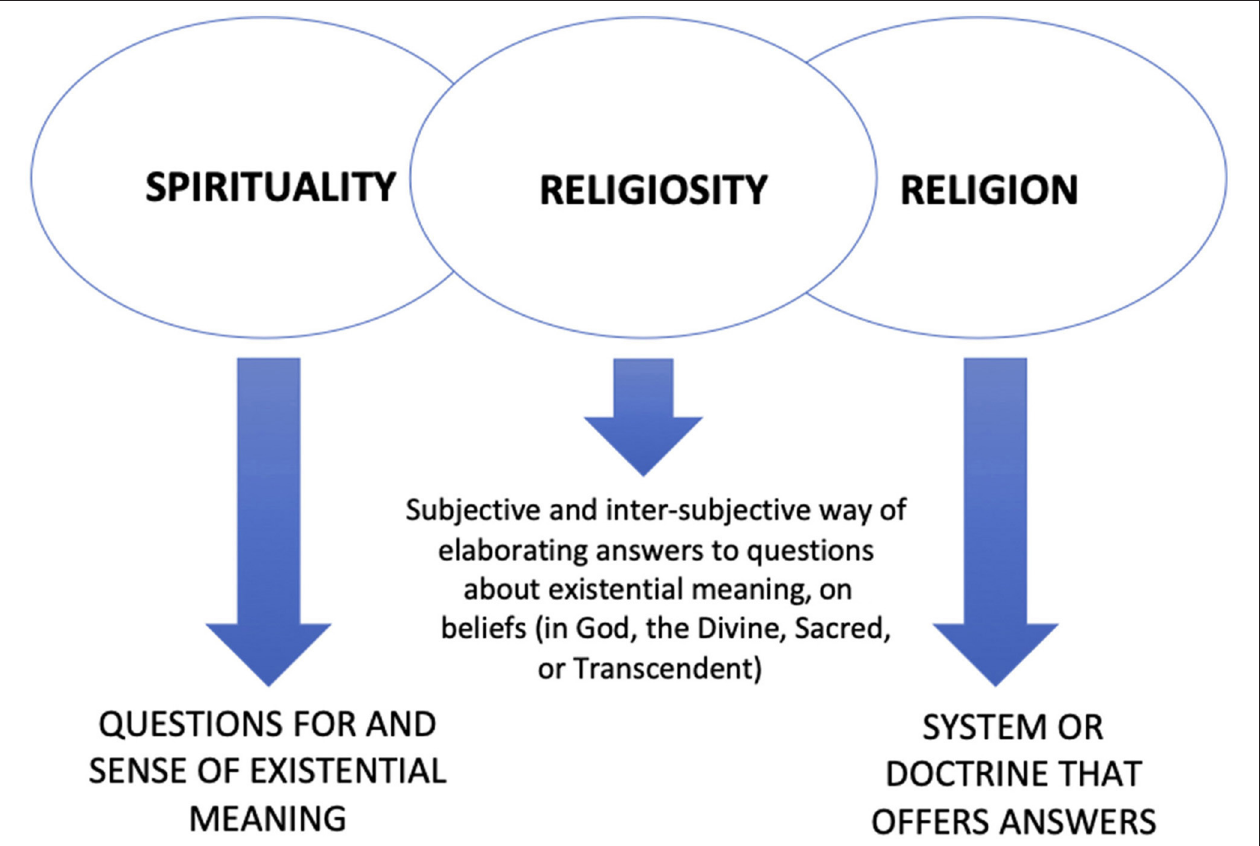
FIGURE 1 | Concepts of spirituality, religiosity and religion based on phenomenology. Reproduced and adapted from Freitas and Vilela (2017, p.